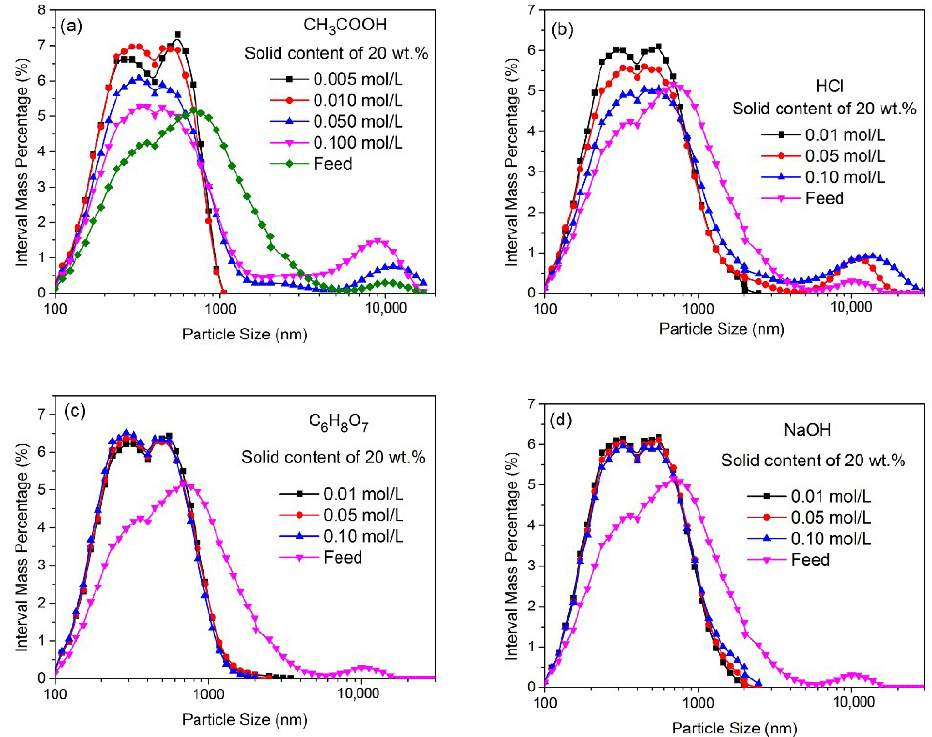
Figure 4. The PSD of ZnO particles ground for 30 min in CH 3 COOH, HCl, C 6 H 8 O 7 and NaOH solu- tions at di ff erent concentrations. ( a ) the interval mass distribution of ZnO particles ground for 30 min in CH 3 COOH solutions at di ff erent concentrations; ( b ) the interval mass distribution of ZnO particles ground for 30 min in HCl solutions at di ff erent concentrations; ( c ) the interval mass distri- bution of ZnO particles ground for 30 min in C 6 H 8 O 7 solutions at di ff erent concentrations; ( d ) the interval mass distribution of ZnO particles ground for 30 min in NaOH solutions at di ff erent con- centrations. Table 3. The d 50 , n and sphericity values of ZnO particles ground for 30 min in the solutions of CH 3 COOH, C 6 H 8 O 7 , HCl and NaOH at di ff erent concentrations.